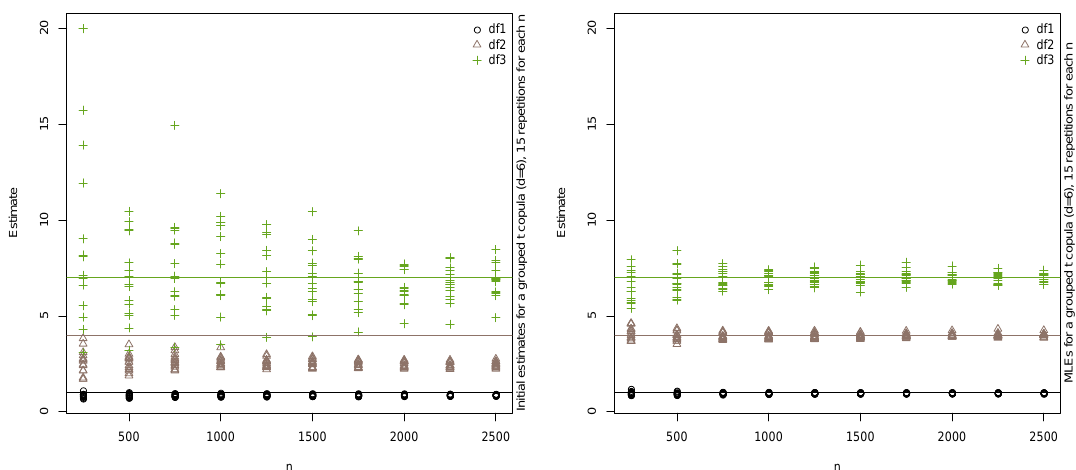
Figure 5. Estimated dof for a 6-dimensional grouped t copula with 3 groups of size 2 each. ( left ) Estimates are obtained by fitting the t copulas of each group separately; ( right ) the joint copula-likelihood of the grouped t copula is